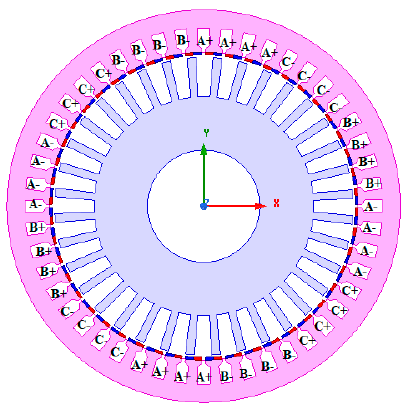
Figure 15. 3-phase, 48 / 46-pole FRM generator for the direct drive [32].